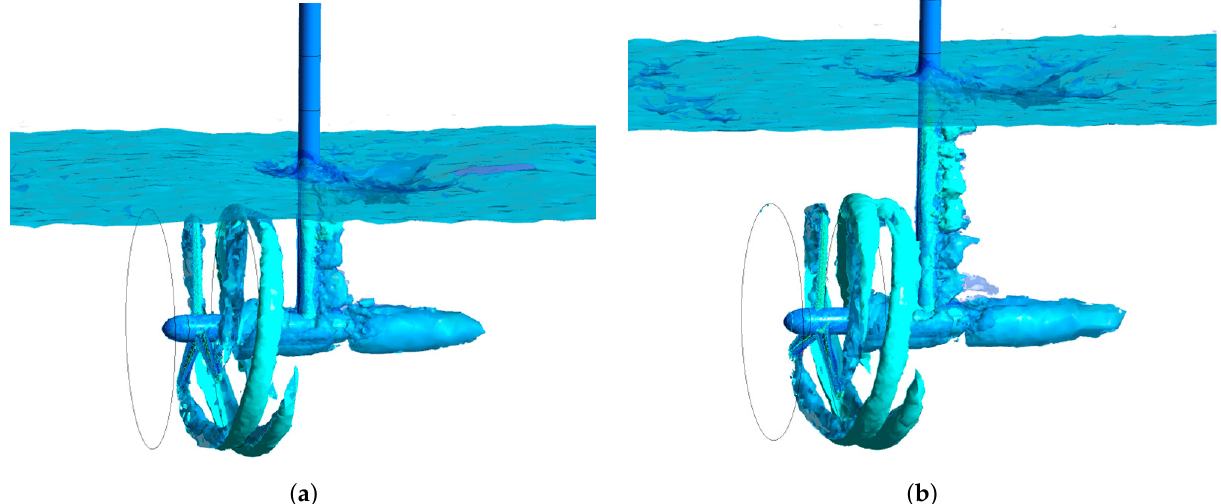
Figure 8. Snapshots of air-water interface and vorticity isosurface of 20 Hz at ( a ) 0.19 D and ( b ) 0.55 D tip